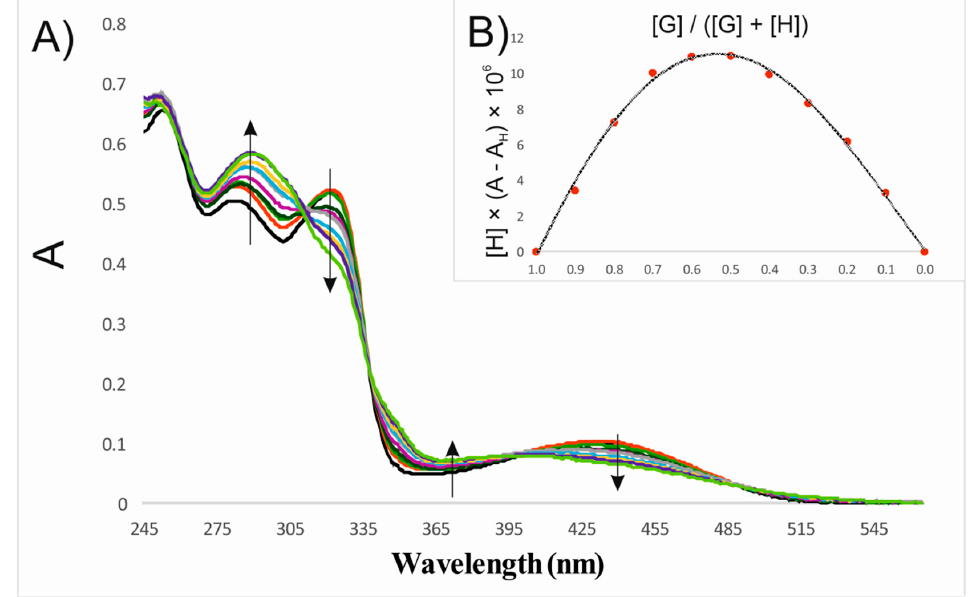
Figure 3. ( A ) UV-vis titration of compound 10 ( 1,3-alternate ) (1 × 10 − 5 M) with the copper (II) cation (CH 3 OH-CHCl 3 (1:1), t = 25 °C); ( B ) Job’s plot of thiacalix[4]arene 10 ( 1,3-alternate ) and Cu 2+ in CH 3 OH:CHCl 3 (1:1). Table 1. Binding constants (log K b ) for copper (II) complexes of the compounds 8 – 11 in the CH 3 OH/CHCl 3 (1:1) mixture at room